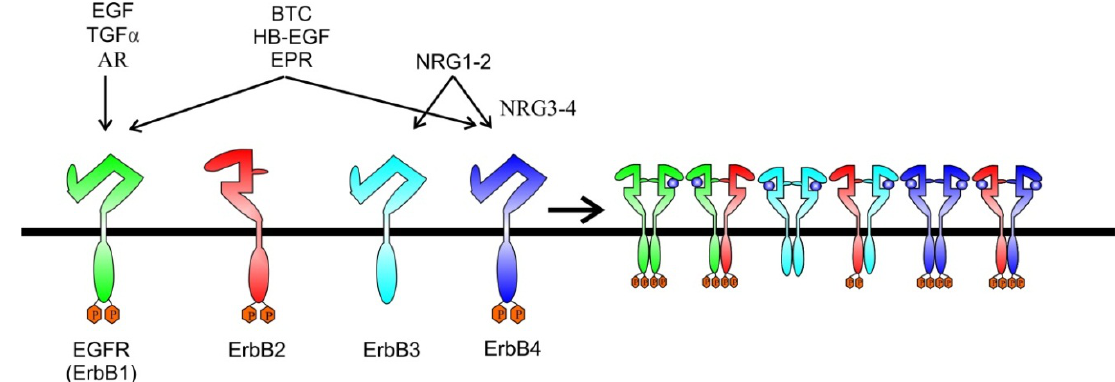
Figure 1. ErbB receptor tyrosine kinases and their ligands ( ). All four members of the ErbB receptor family share high homology in the extracellular domain and the kinase domain. However, ErbB3 lacks tyrosine kinase activity. So far no ligand has been found for ErbB2, which has been found to be the preferred dimerization partner for other receptors. EGFR (ErbB1), ErbB2, ErbB3 and ErbB4 have different ligand binding and signaling. EGF, epidermal growth factor; TGF α , transforming growth factor alpha; AR, amphiregulin; EPR, epiregulin; BTC, betacellulin; HB-EGF, heparin binding EGF; NRG, neuregulin. Ligand binding causes homo/heterodimerization by ErbB family members enhancing complexity of signal